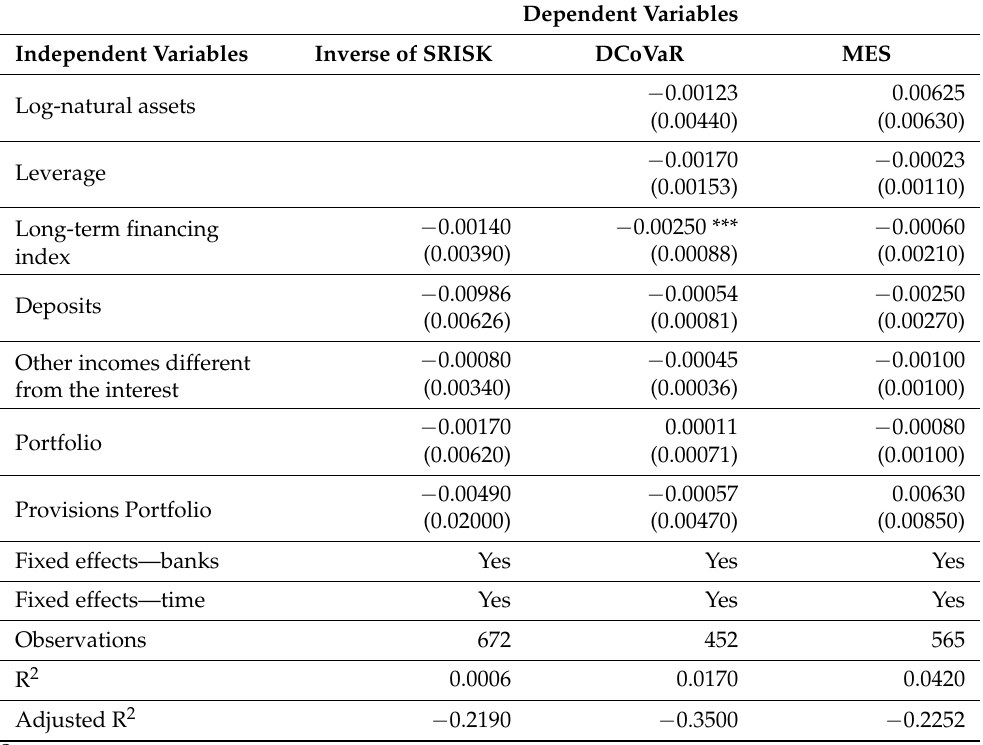
Table 5. Results of the explanatory power of the characteristics of the